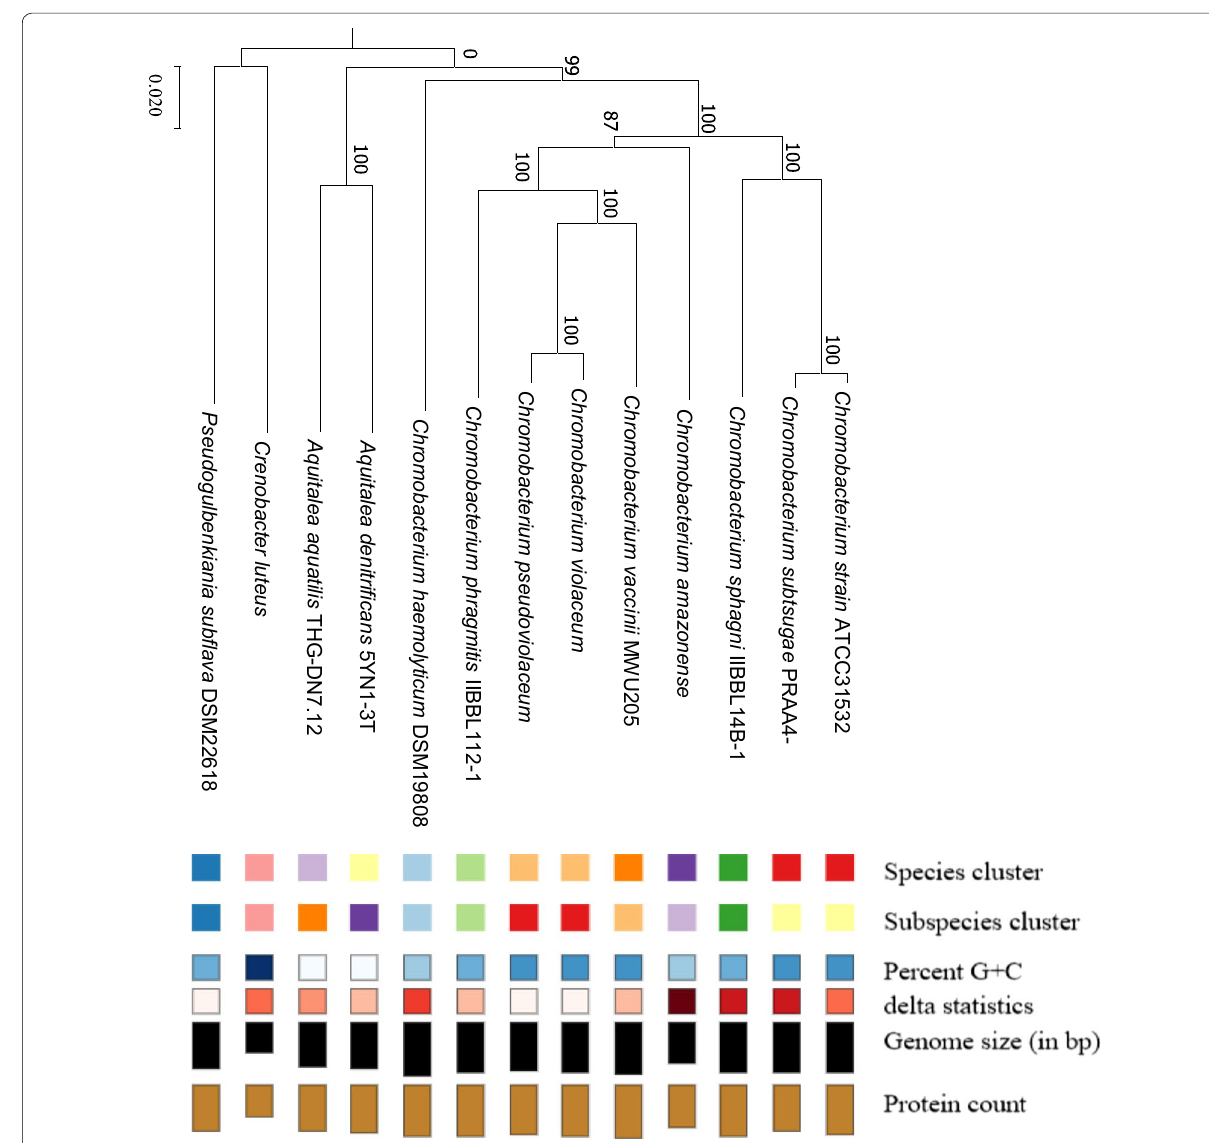
Fig. 1 A tree was inferred with FastME 2.1.6.1 from minimum MASH distances. Branch lengths are scaled to Genome BLAST Distance Phylogeny distance formula d5. Pseudo-bootstrap values are shown at the nodes, and are based on 100 replications. The tree has a mean branch support of